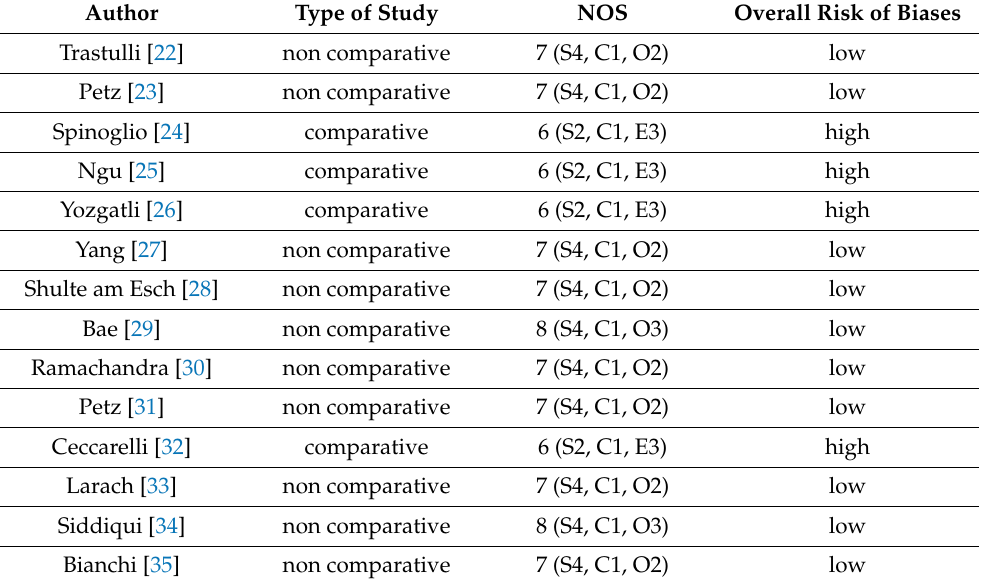
Table 2. Risk of